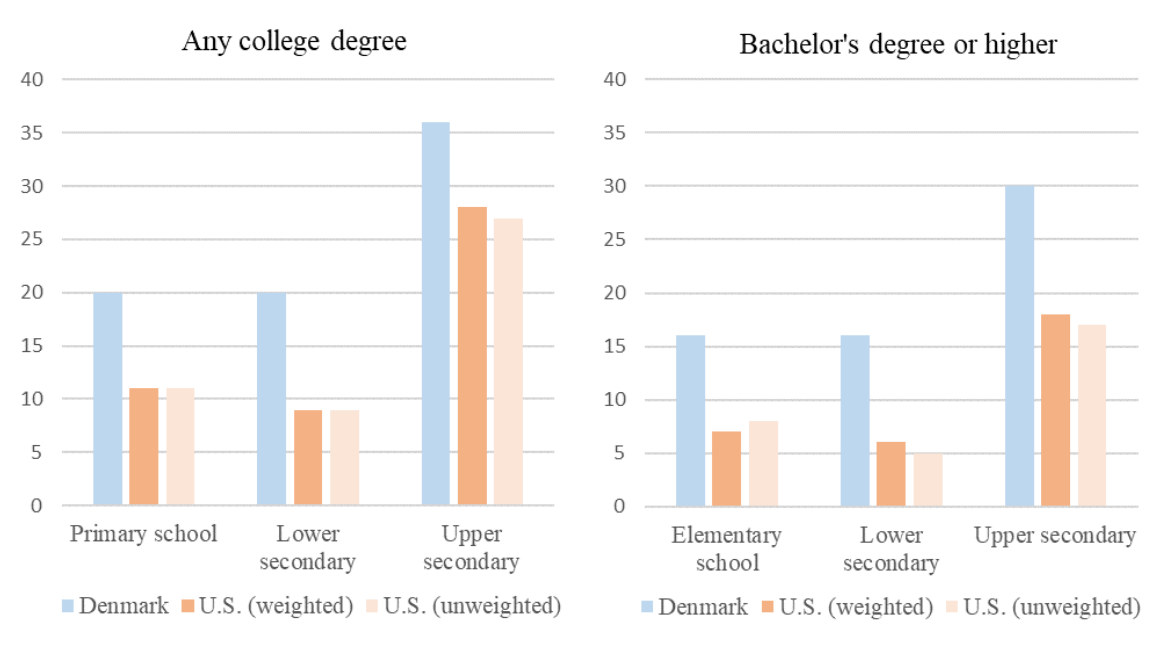
Figure 1: Share of children who obtain any college degree or at least a bachelor’s degree by parents’ education (only lower educated parents shown). Notes : Primary school comprises grades 0/1 to 7, lower secondary grades 8 to 11; upper secondary comprises high school diploma, gymnasium, and vocational education and training. “Any college degree” is any higher education degree. Denmark: n = 250,956; United States: n =